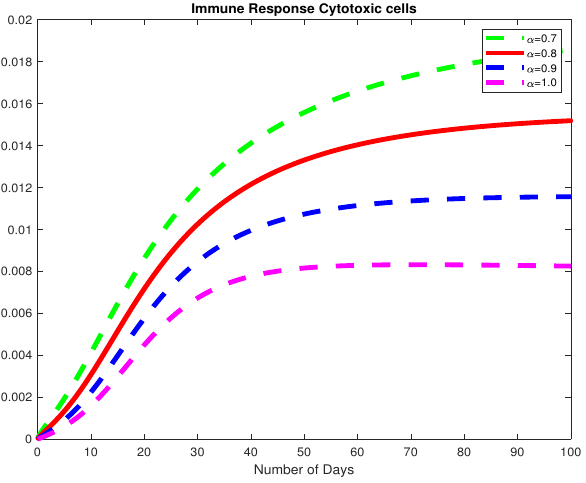
Figure 8. The dynamics of the immune response cytotoxic cells, R , for varying fractional order α